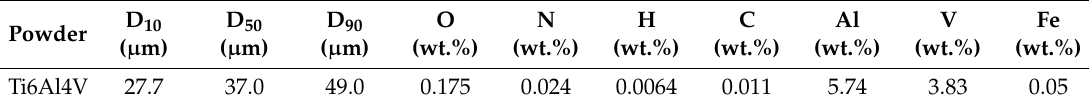
Table 2. Relevant information about the powder used in this